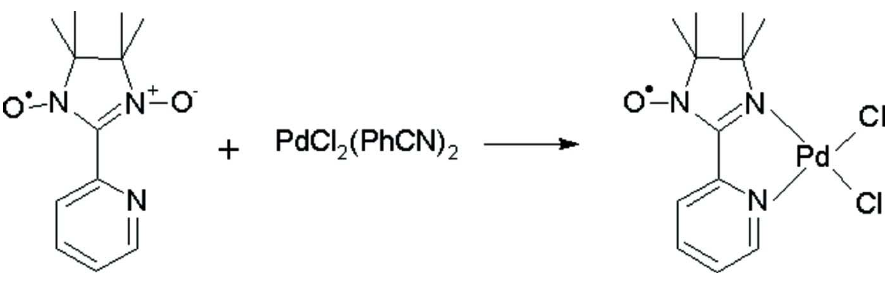
Figure 3 The formation of the title